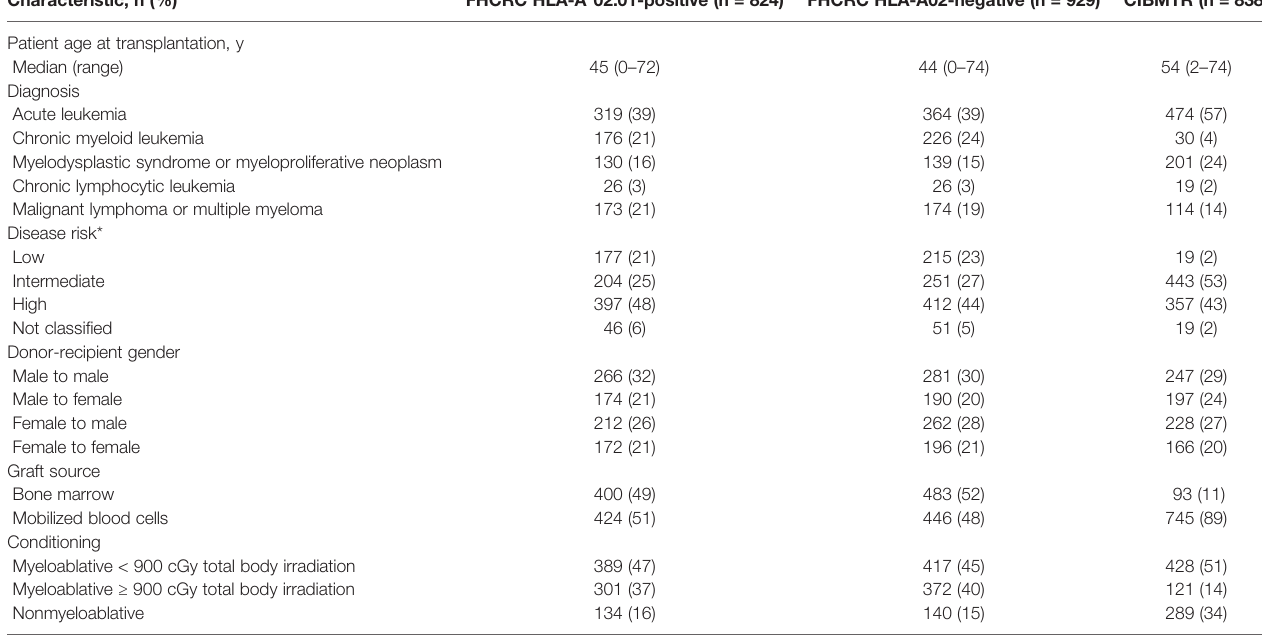
TABLE 1 | Characteristics of the study cohorts. Characteristic, n